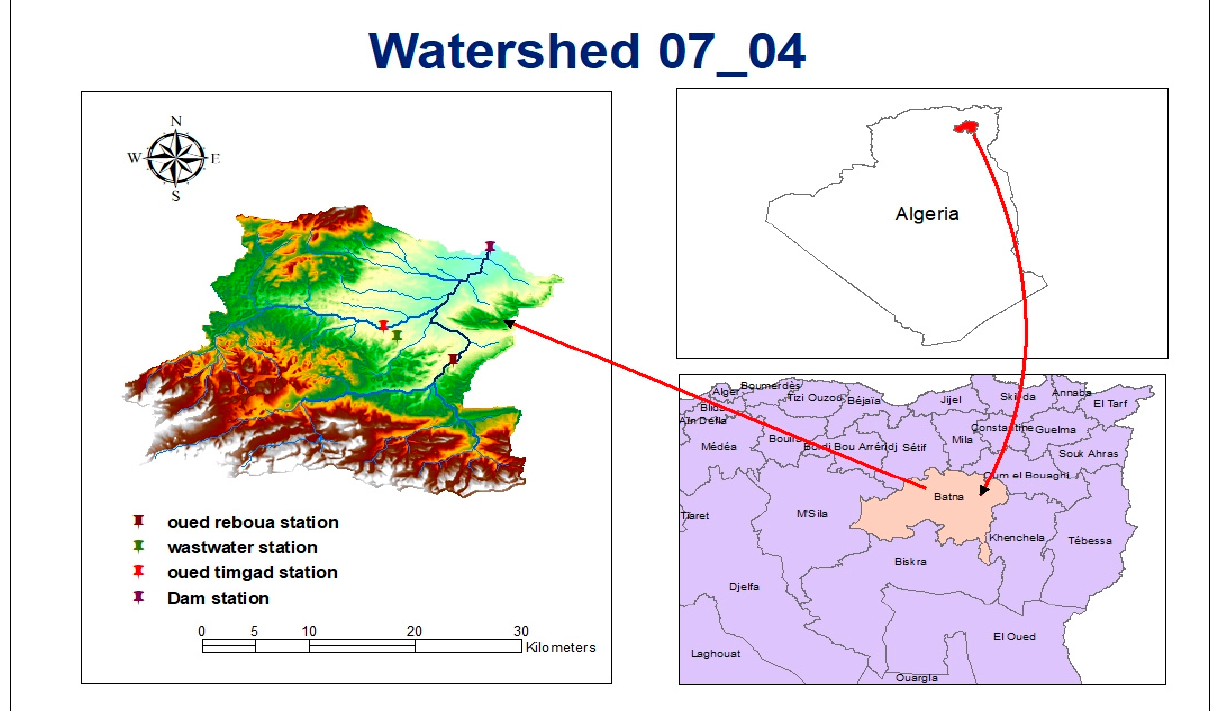
Figure 1. Location of the study area and sampling points.